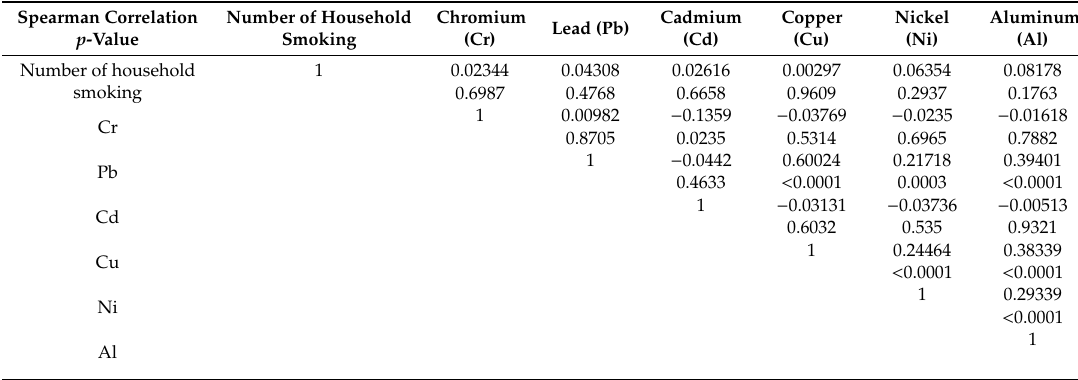
Table 4. Correlations between the toenail heavy metal concentrations ( µ g / g) and number of smokers in